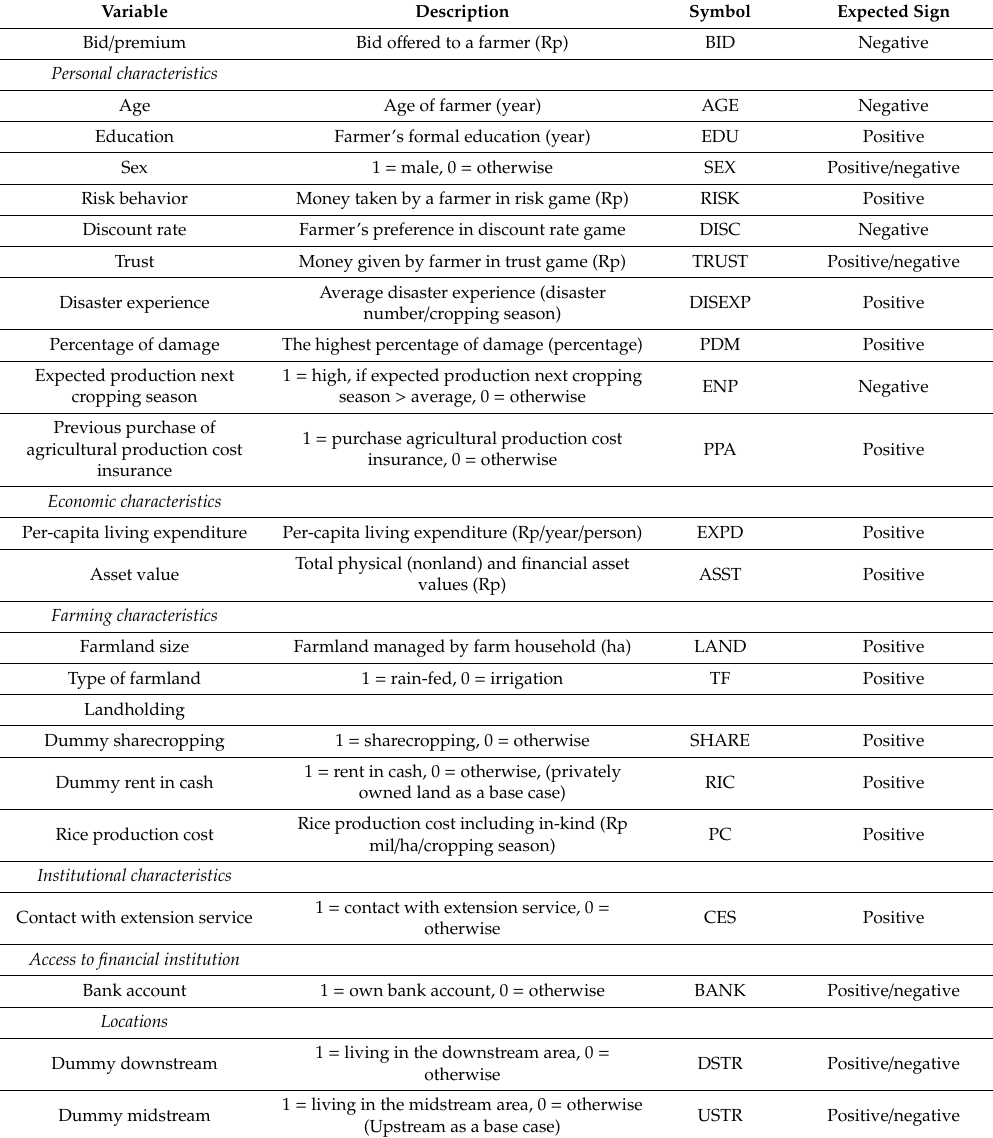
Table 1. Variables taken in the